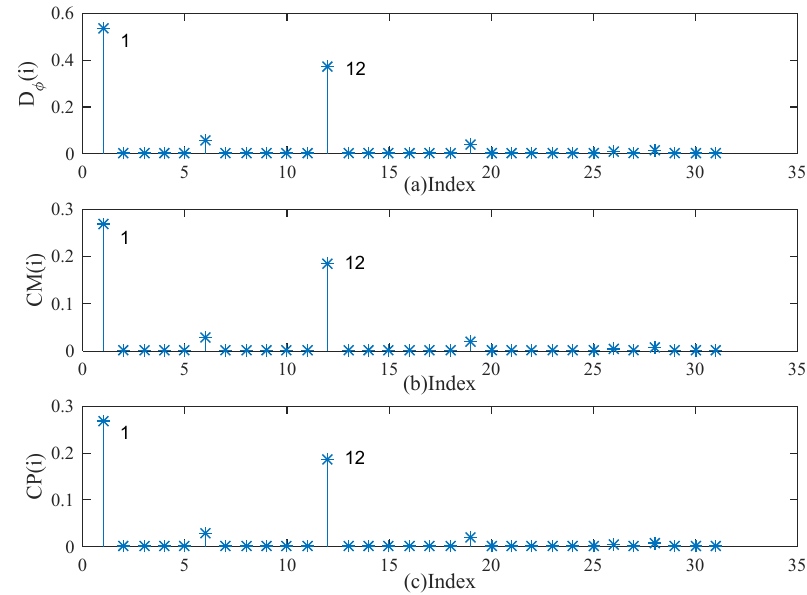
Figure 10. Diagnostic plots of response variables outliers in the real example.